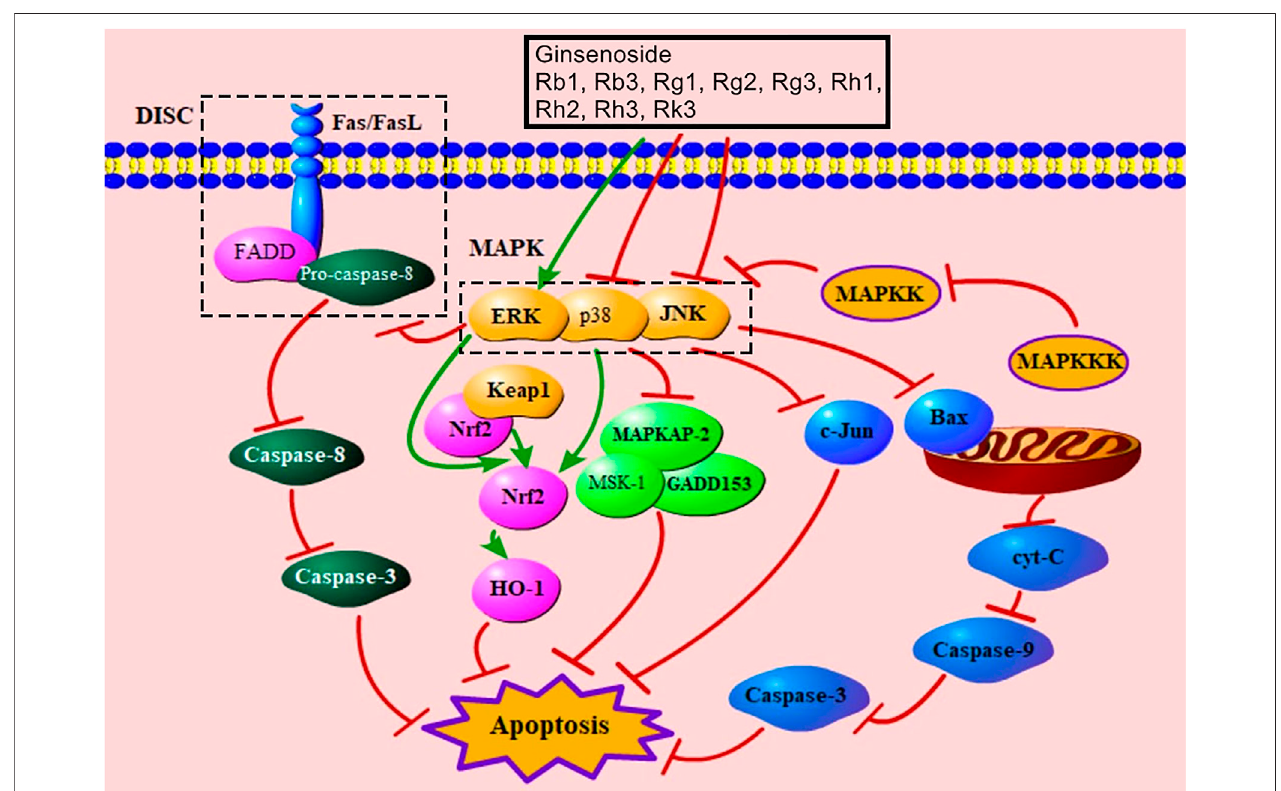
FIGURE 7 | MAPK-mediated signaling pathway of ginsenoside in relieving MC apoptosis. DISC, death-induced signal complex; FasL, Fas ligand; FADD, Fas- associated death domain protein; MAPK, mitogen-activated protein kinase; ERK, extracellular signal – regulated kinase; Keap1, Kelch-like ECH-associated protein 1; Nrf2, nuclear factor E2 – related factor 2; HO-1, heme oxygenase-1; MAPKAP-2, MAPK-activated protein kinase-2; MSK-1, mitogen- and stress-activated protein kinase; MAPKK, MAPK kinase; MAPKKK, MAPK kinase kinase; c-Jun, c-Jun N-terminal kinase; cyt-C, cytochrome